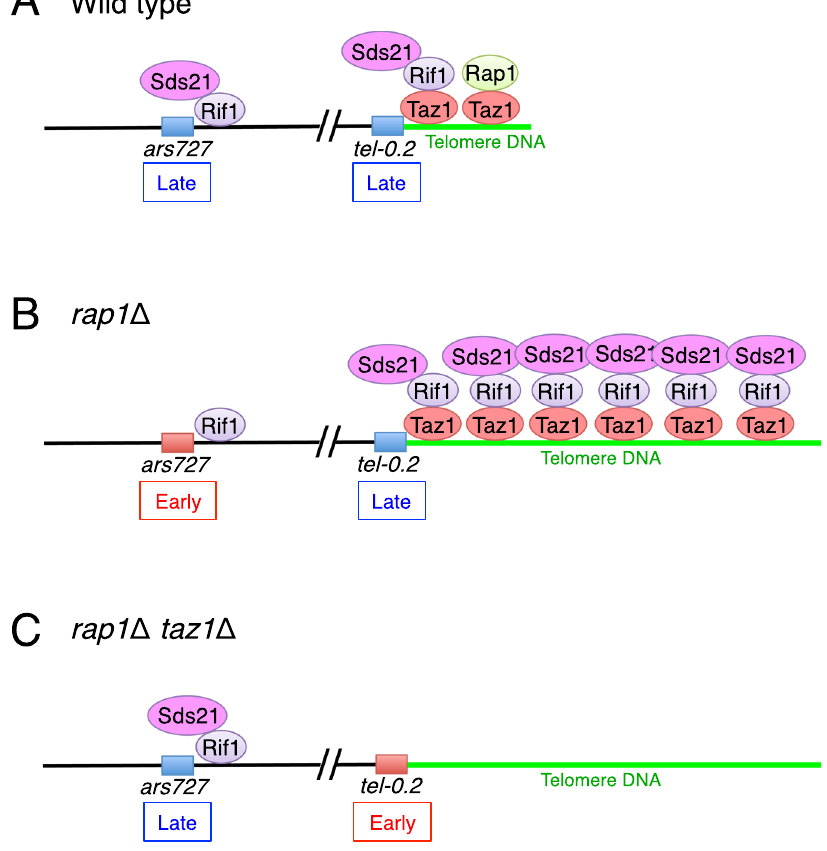
Figure 6. Model of replication timing control based on telomere DNA length. ( A ) In wild-type cells, the PP1 Sds21 is recruited to telomeres and late origins such as ars727 , a Taz1-independent origin, through association with Rif1. Localization of Sds21 at ars727 maintains replication timing at this site in late S phase. Rif1 associates with telomeres via Taz1. ( B ) In rap1 ∆ cells, telomere DNA is excessively elongated, resulting in the accumulation of Sds21 via Taz1–Rif1 complexes. Sequestration of Sds21 at telomeres reduces Sds21 localization at ars727 and accelerates replication timing in early S phase. ( C ) In taz1 ∆ rap1 ∆ cells, Sds21 is released from elongated telomeres, which restores Sds21 localization at ars727 and normal replication timing in late S phase. In contrast, the absence of Sds21 at telomeres accelerates replication timing at tel-0.2